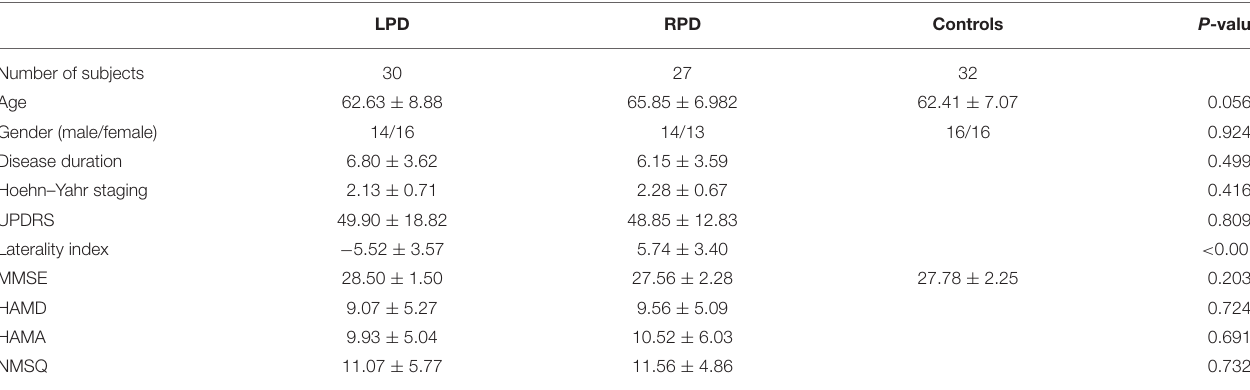
TABLE 2 | Demographic and clinical information of PD patients and controls.